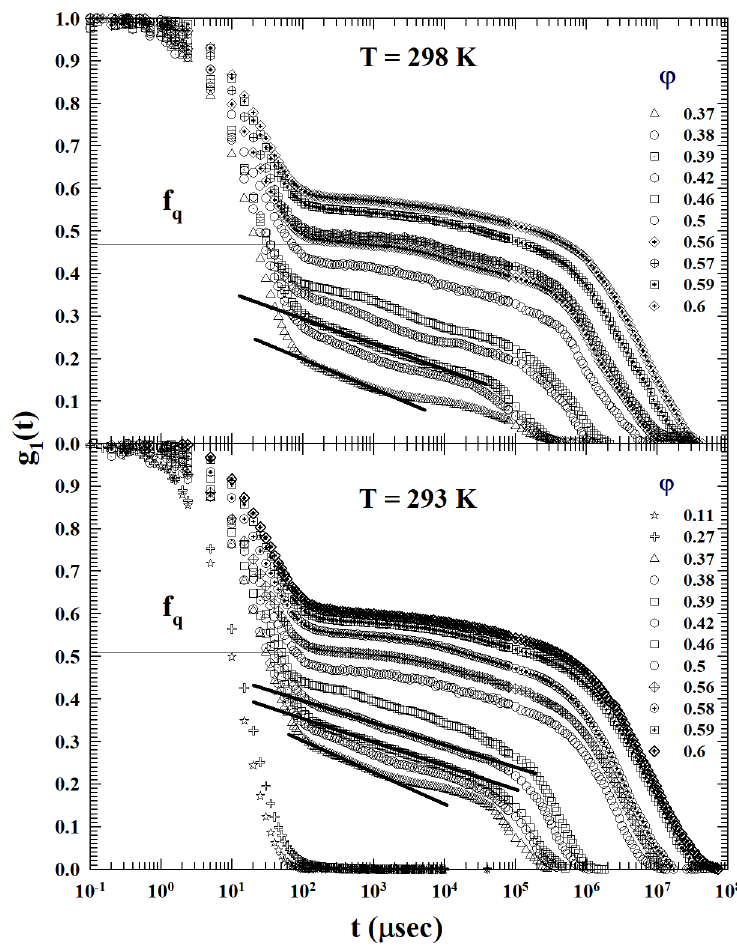
Figure 2. The dendrimer-methanol ISFs, at the different ϕ for T = 298 and 293 K show that a T decrease leads to an increase of the concentration range in which the logarithmic decay exists.